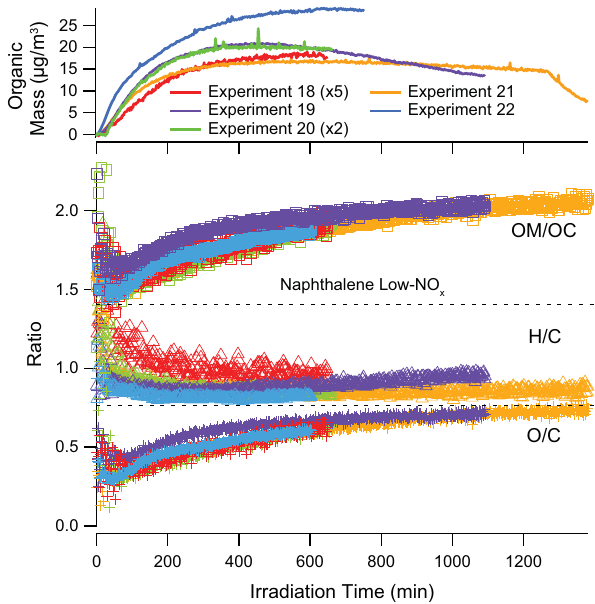
Fig. 12. AMS organic mass (not corrected for collection efficiency), elemental ratios, and OM/OC for naphthalene low-NO x experi- ments. Experiment 18 is in red, 19 in purple, 20 in green, 21 in orange, and 22 in blue. Dotted lines are provided to visually sepa- rate different